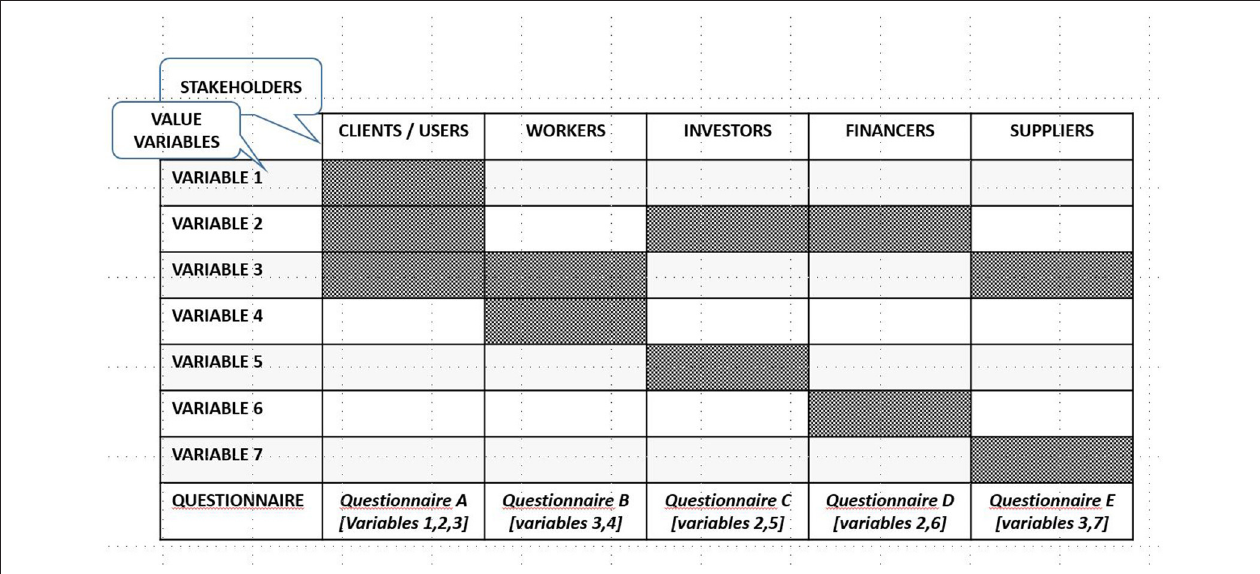
FIGURE 6 | Matrix for the variable and stakeholder synthesis. Source: own